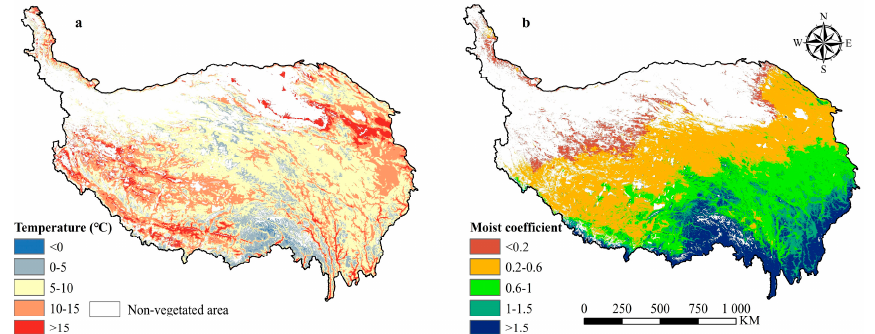
Figure 5. The perennial mean ( a ) temperature and ( b ) moist coefficient in the growing season of the vegetated areas during 2000–2019.